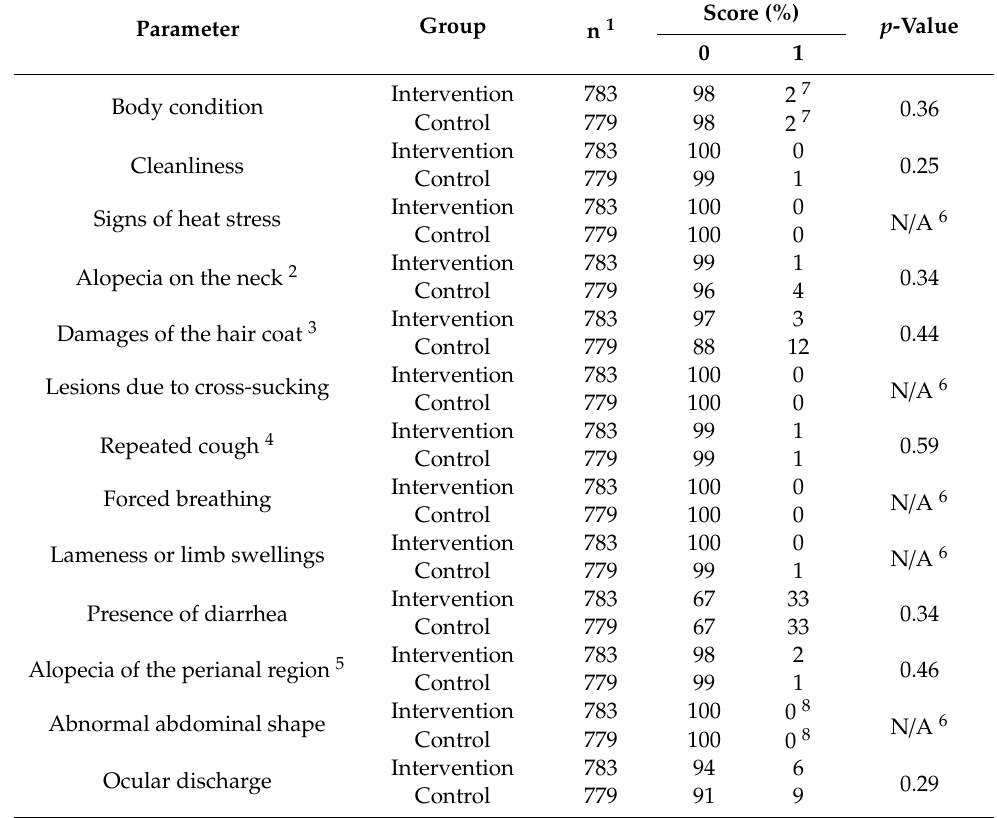
Table 6. Comparison of health and welfare scores at an individual animal level in intervention and control farms (783 and 779 calves, respectively) during the last farm visit before slaughter using Chi-Square